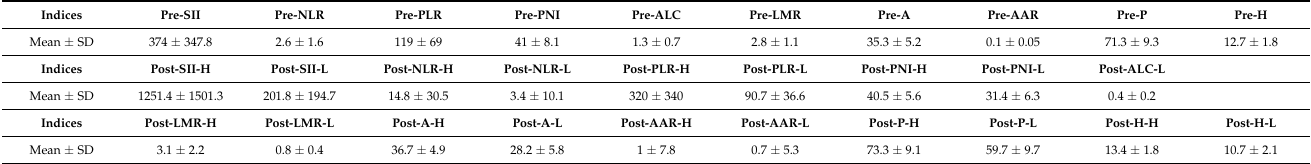
Table 3. Numerical distribution of pre- and posttreatment serum indices.